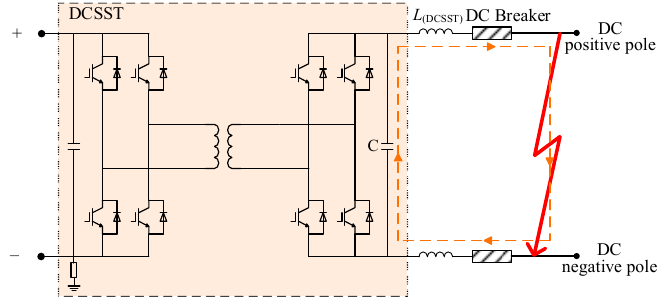
Figure 9. The first stage discharge circuit of DCSST fault.